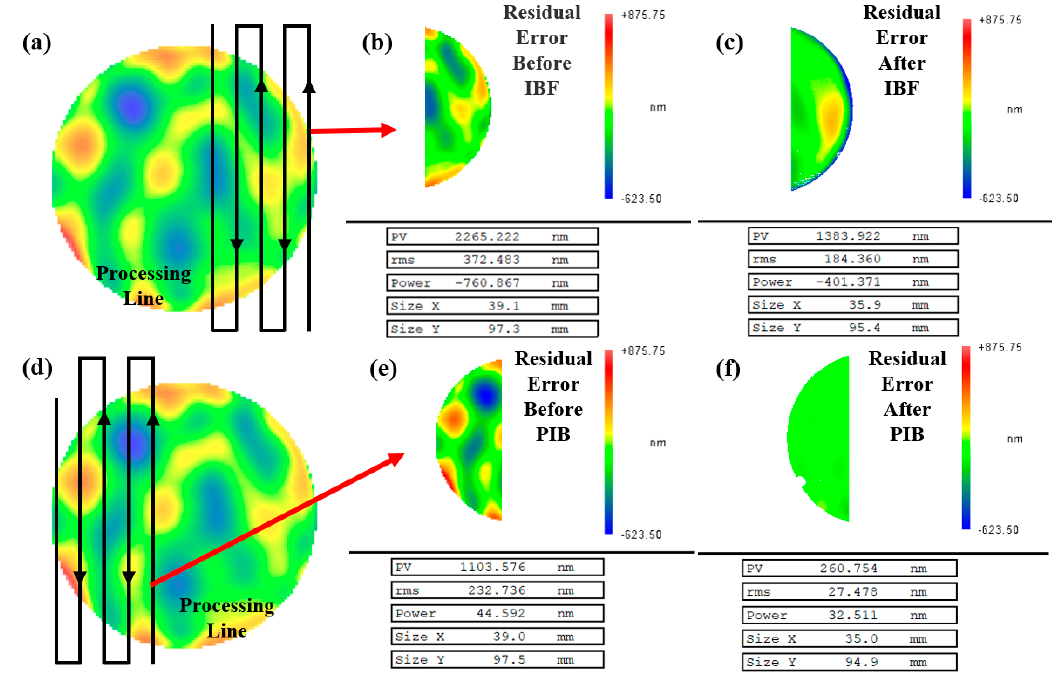
Figure 4. ( a ) Actual machining area of IBF. ( b ) Residual before IBF processing. ( c ) Residual after IBF processing. ( d ) Actual machining area of PIB. ( e ) Residual before IBF processing. ( f ) Residual after PIB processing. Table 1. The PIB and IBF processing parameters.